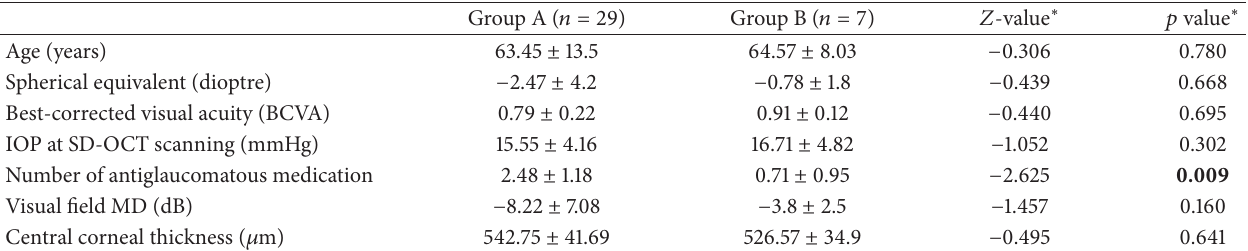
Table 1: Clinical characteristics of the patients.